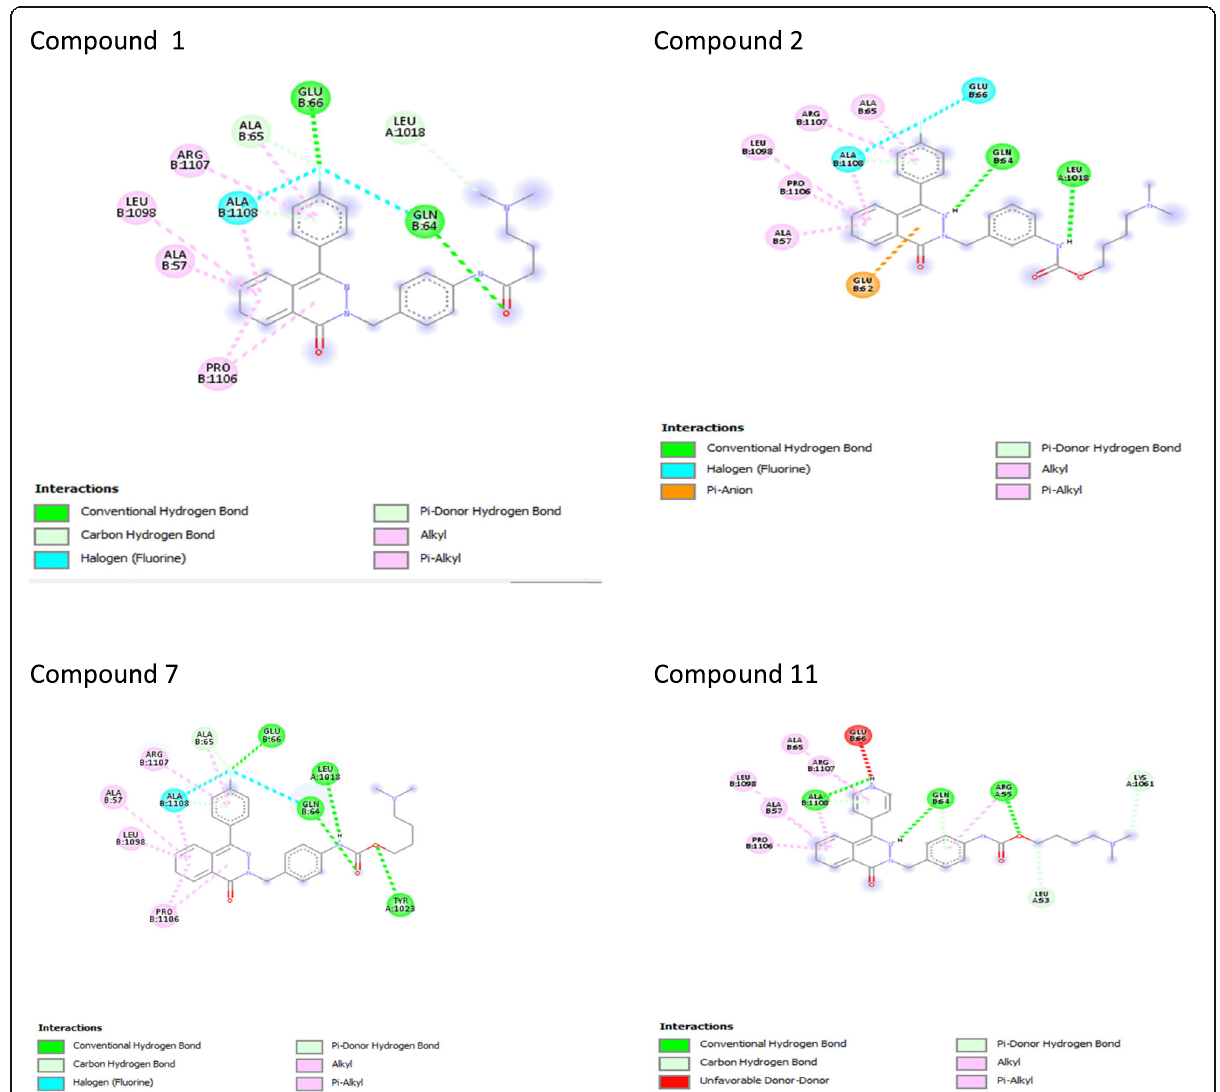
Fig. 6 2-D interaction type for ligands 1, 2, 7, and 11 with different amino acids in the active site of DENV2